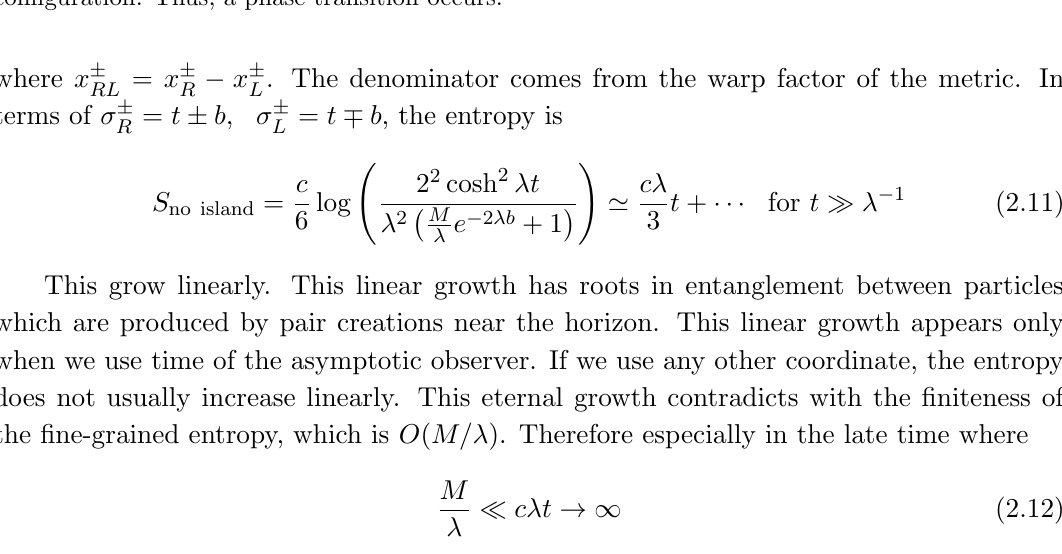
Figure 2 . We add the interval [ a L ; (cid:0) a R ] in (cid:27) coordinates. This island region lies on the non-zero time t 0 slice. After the Page time t Page , this entropy becomes less than the entropy of no-island con(cid:12)guration. Thus, a phase transition